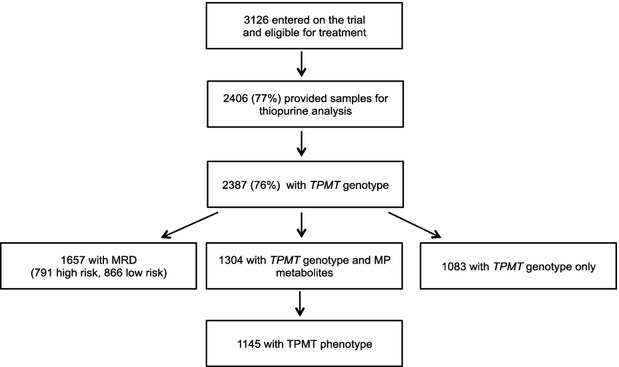
ALL2003 trial data profile. The numbers of individual patients providing blood samples for thiopurine analysis. TPMT, thiopurine methyltransferase; MP, mercaptopurine; MRD, minimal residual disease.